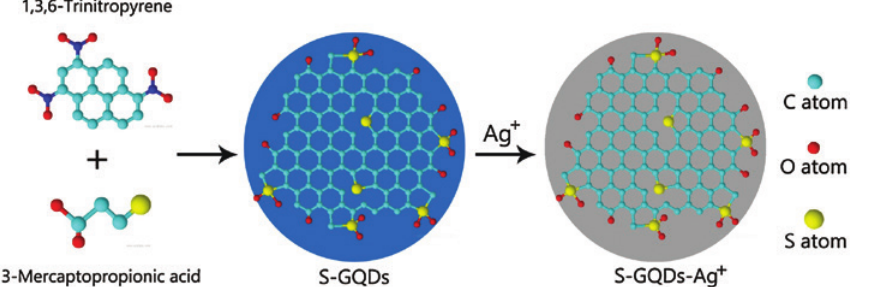
Figure 14: Schematic illustration for the preparation of blue S-GQDs and turn-off detection of Ag + (reprinted/reproduced with the permis- sion of Ref. [101], copyright 2017, Elsevier